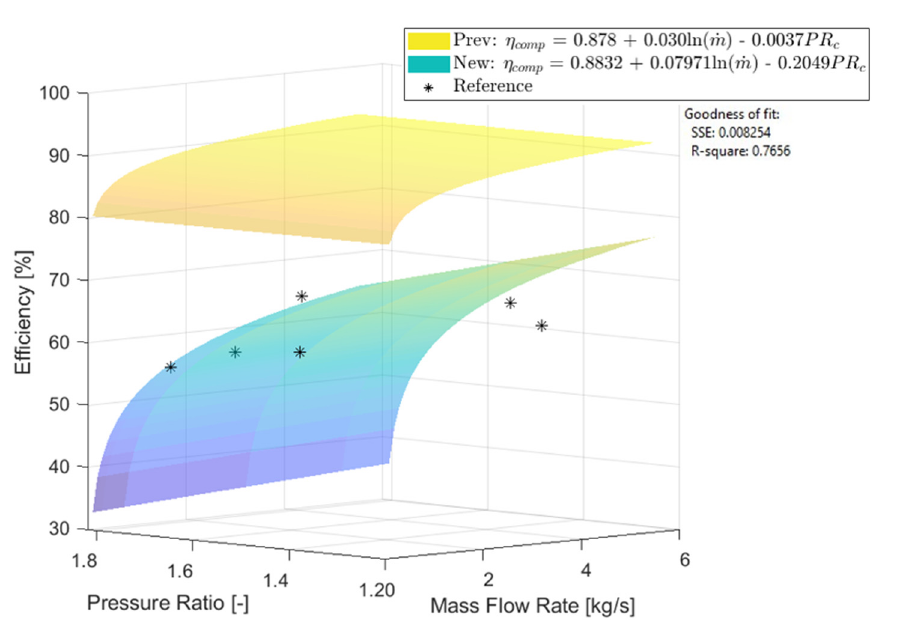
Figure 9. Comparison for new S-CO 2 compressor polytropic efficiency equation.